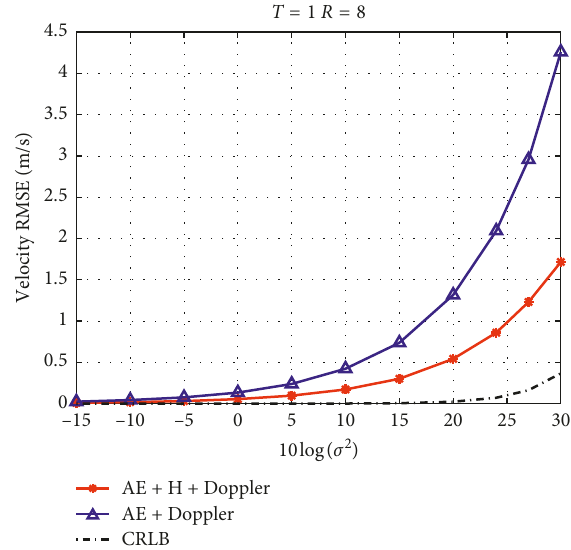
Figure 6: Comparison of the velocity RMSE of the proposed method with AE+Doppler and CRLB when T � 1, R � 8. The ac- curacy is lower as the noise power